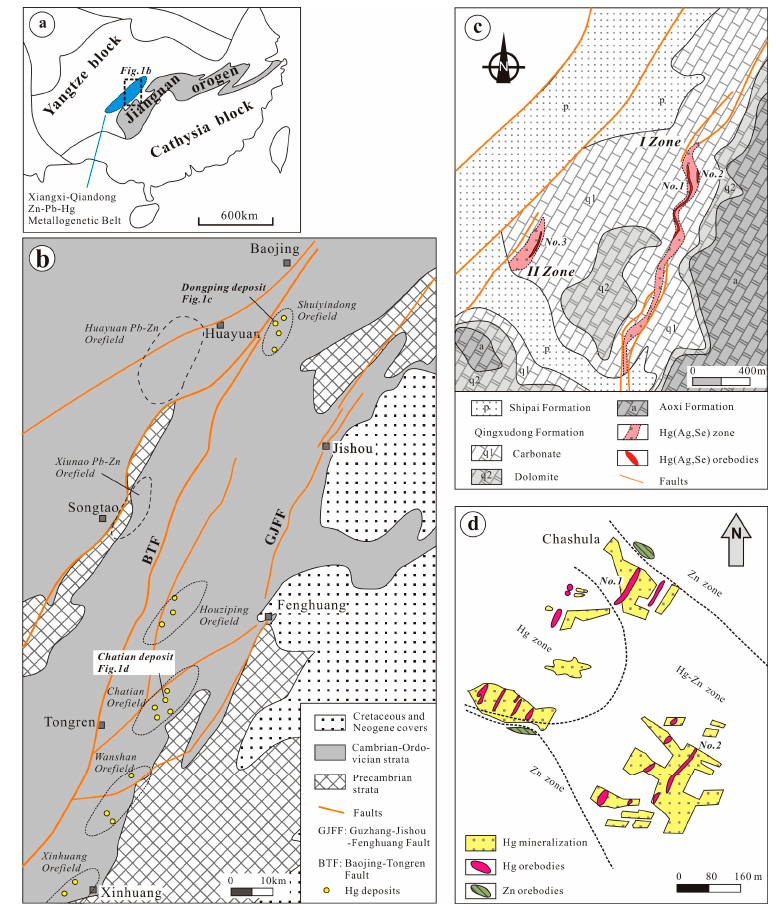
Figure 1. ( a ) Map of the tectonic units in southern China, showing the Xiangxi – Qiandong Pb – Zn – Hg metallogenic belt located in the southeast of the Yangtze Block and the Jiangnan orogen belt; ( b ) simplified geological map of western Hunan – Eastern Guizhou region showing distribution of Hg orefield and adjacent Pb – Zn orefield (after HBGMR, unpublished maps); ( c ) geological map of the Dongping deposit (after [40]); and ( d ) simplified geological map of the Chashula deposit, showing the distribution of Hg, Hg – Zn, and Zn mineralization zones (after [41]).